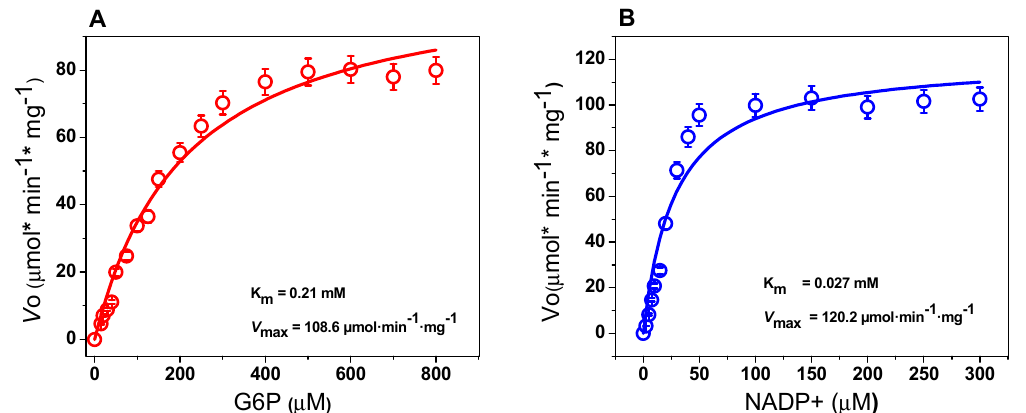
Figure 5. Michaelis–Menten plots for fused TvG6PD::6PGL with ( A ) G6P and ( B ) NADP + as substrates. The data represent the mean ± SD from five independent experiments. Table 1. Steady-state kinetic parameters of the fused TvG6PD::6PGL and the other G6PDs previously reported.